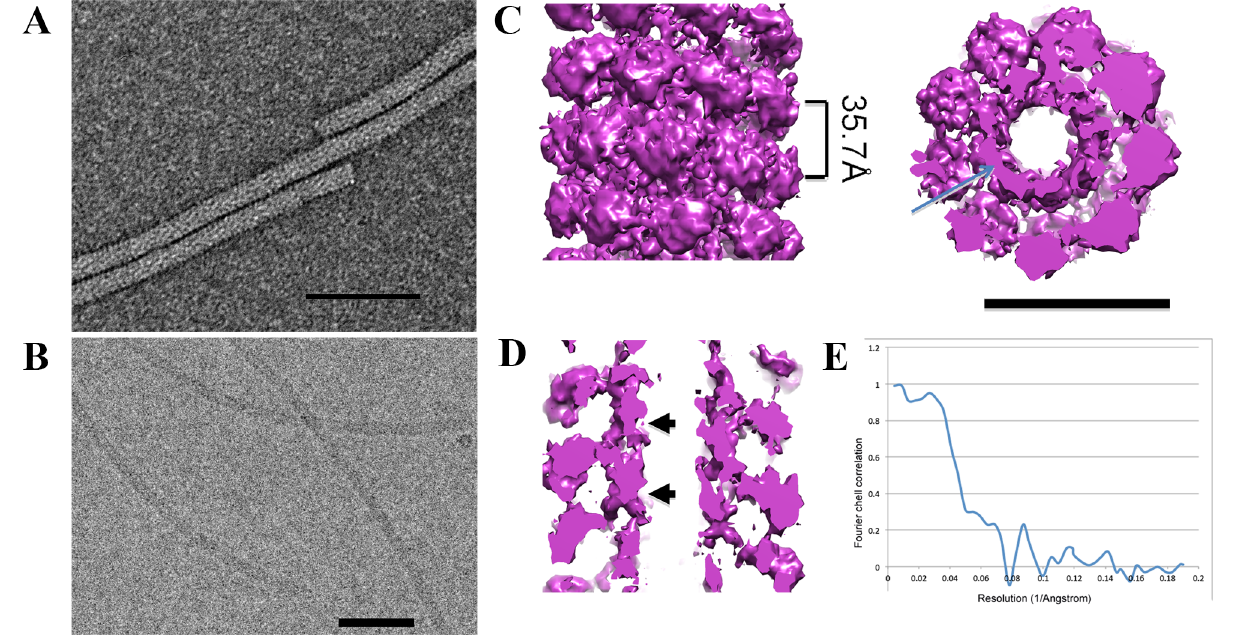
Fig 1. EM analisys of AltMV virions. A. Transmission electron microscopy (TEM) of AltMV virions. Samples were stainedwith 2% uranyl acetate. Bar– 100 nm. B. Cryo-electron microscopy of AltMV virions. Bar– 100 nm. C. 3D reconstruction: on the left– surfaceof AltMV virion, on the right– horizontal slice of AltMV virion. Bar– 10 nm. D. Vertical slice of AltMV virion, possibleRNA locationis marked with an arrow. E. FSC